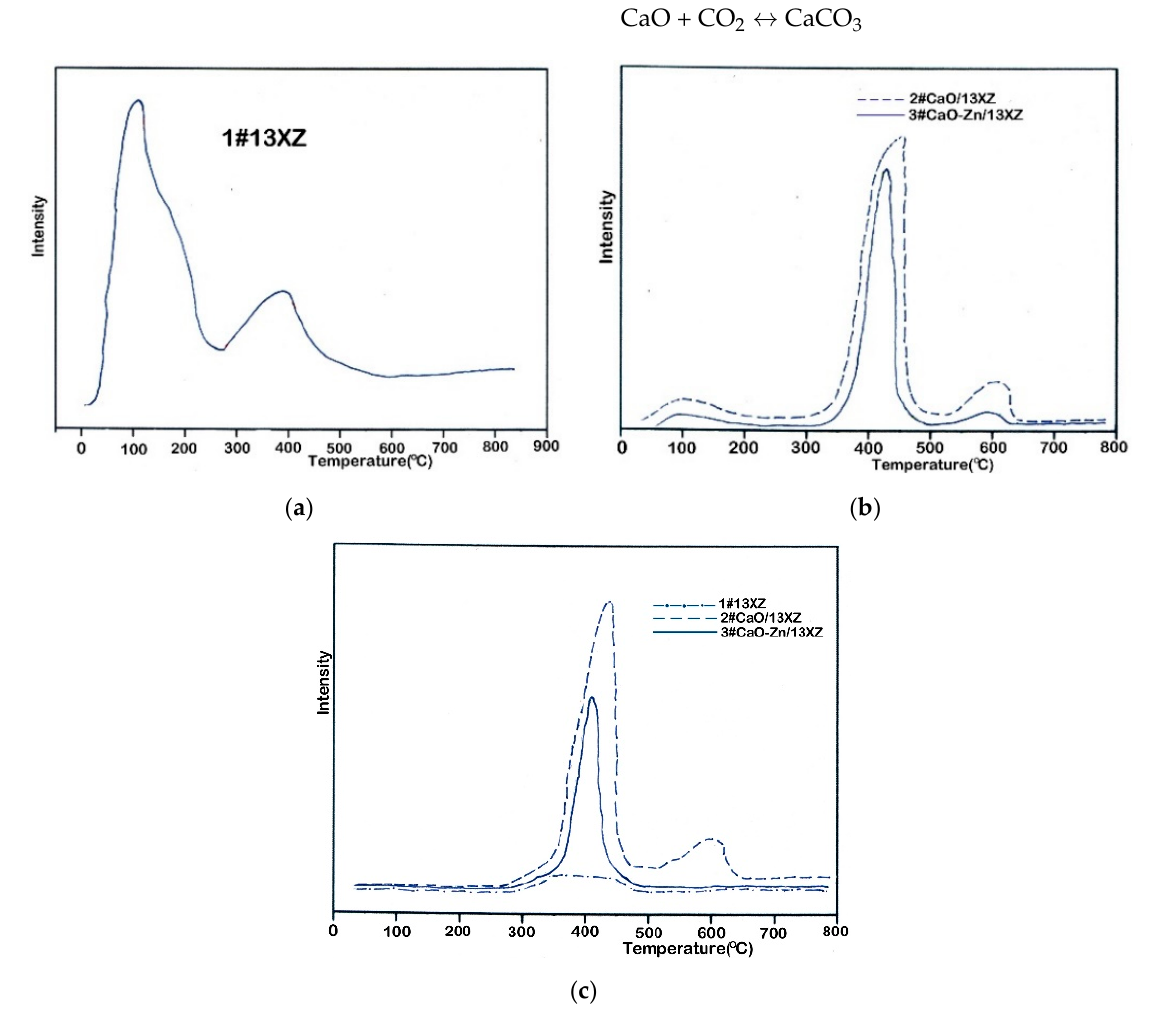
Figure 9. NH 3 -TPD diagrams: ( a ) NH 3 -TPD diagram of fresh 1# 13XZ; ( b ) NH 3 -TPD diagrams of fresh 2# CaO/13XZ and 3# CaO-Zn/13XZ nanocomposites; ( c ) CO 2 -TPD results of the used 1# 13XZ, 2# CaO/13XZ and 3# CaO-Zn/13XZ.